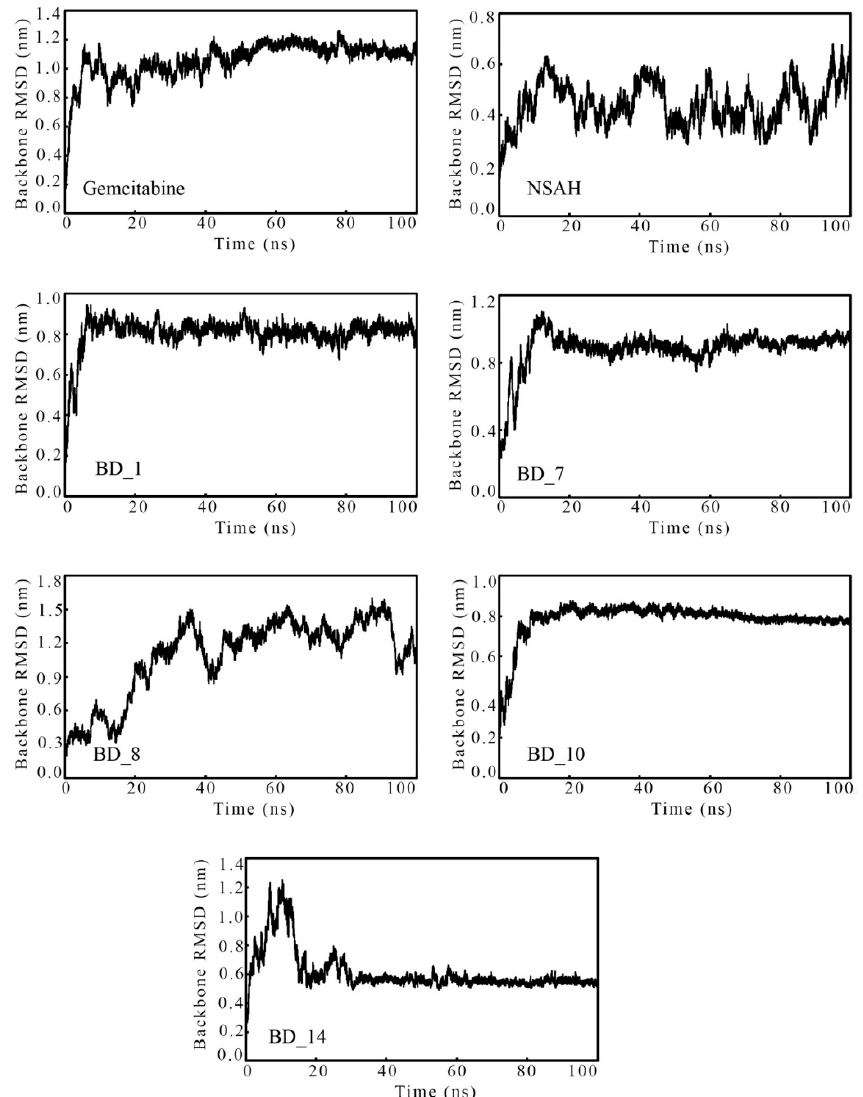
Figure 6. The hRRM1 backbone RMSD bound with gemcitabine, NSAH, and proposed hRRM1 inhibitors over time of simulation.